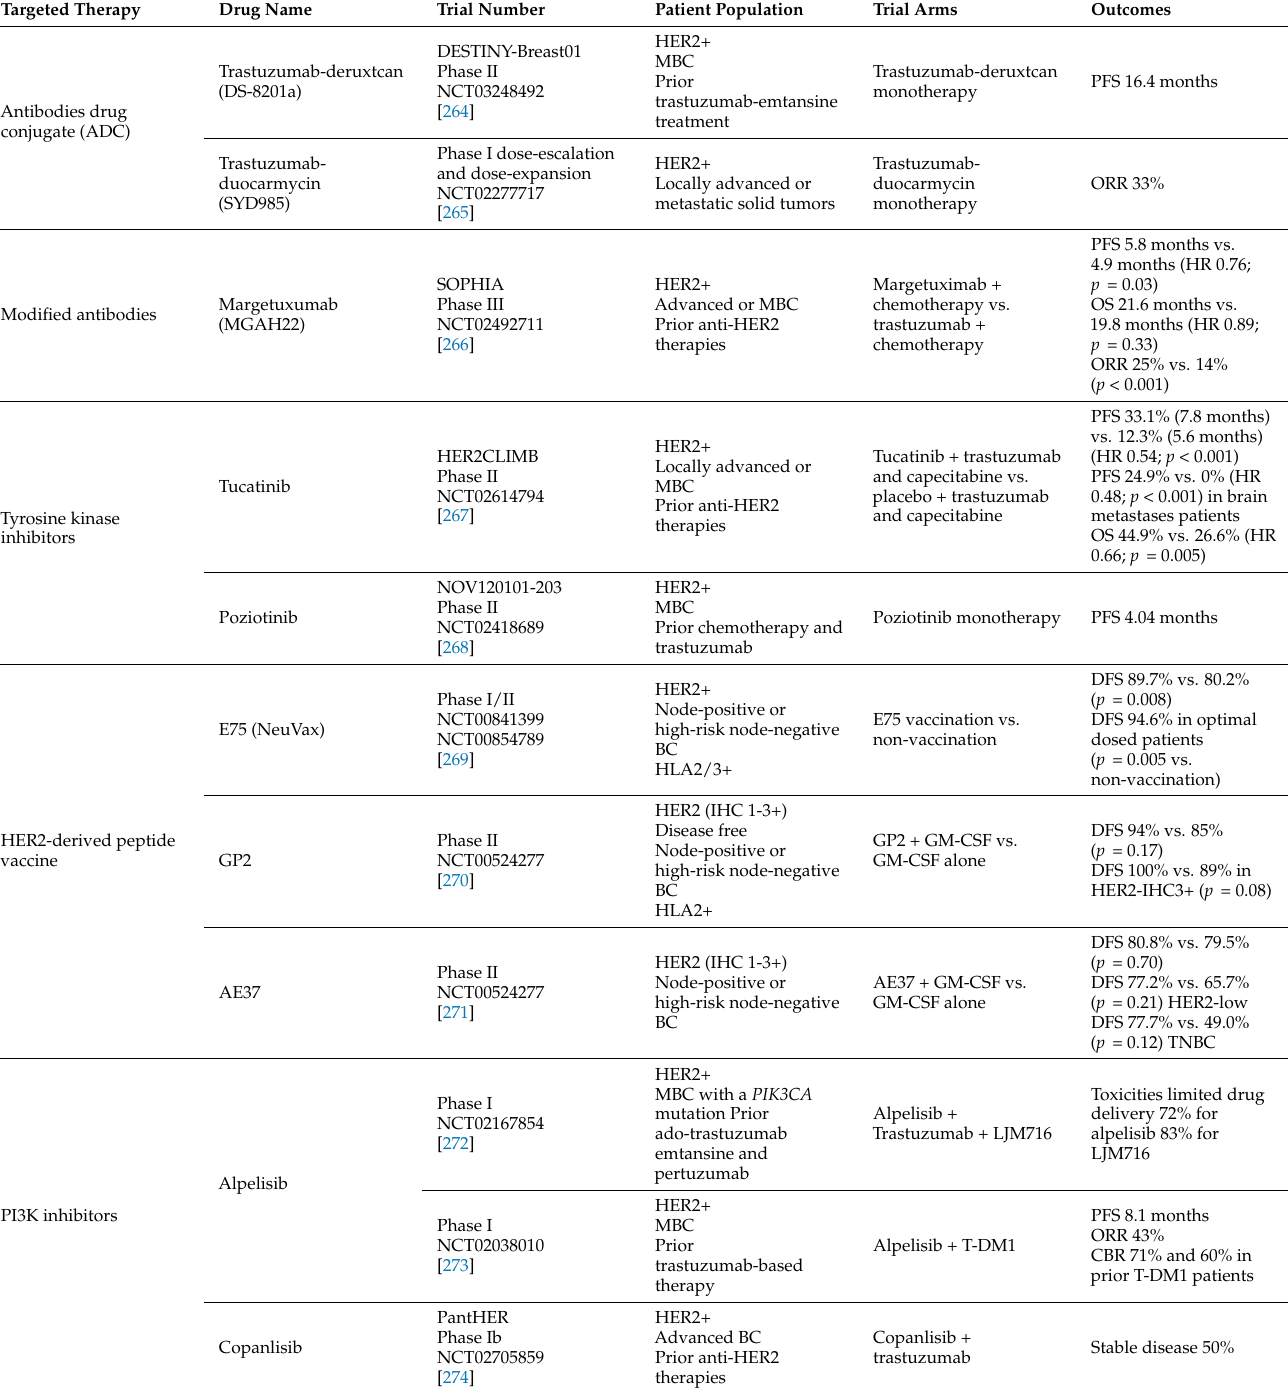
Table 2. Most recent completed clinical trials on emerging therapies for HER2+ breast